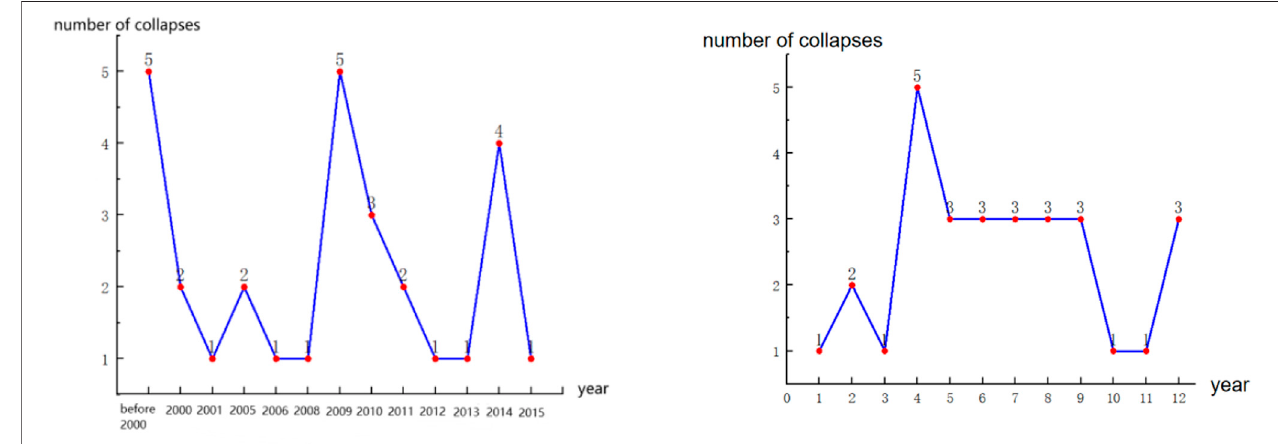
FIGURE 4 | Temporal distribution of karst collapse in the study area